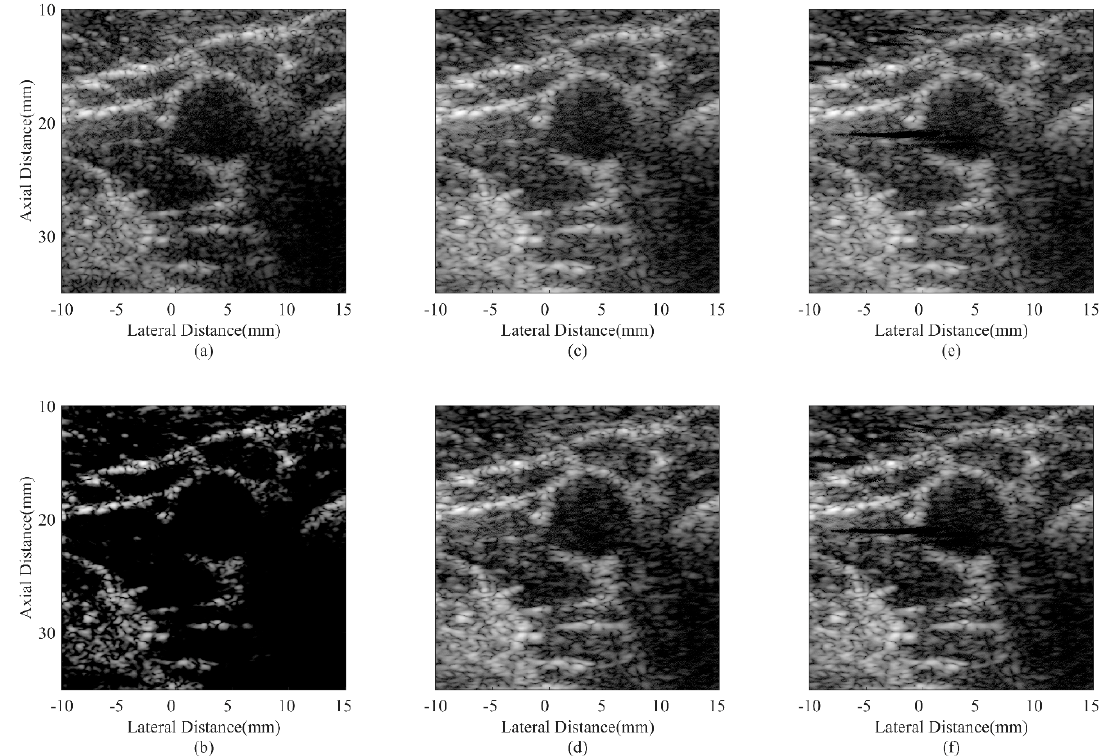
Figure 8. In vivo human carotid artery images using different beamformers: ( a ) DAS, ( b ) CF, ( c ) JTR-MV, ( d ) JTR-MV GCF, ( e ) JTR-ESBMV, ( f ) JTR-ESBMV GCF. All images are shown with a dynamic range of 60 dB.